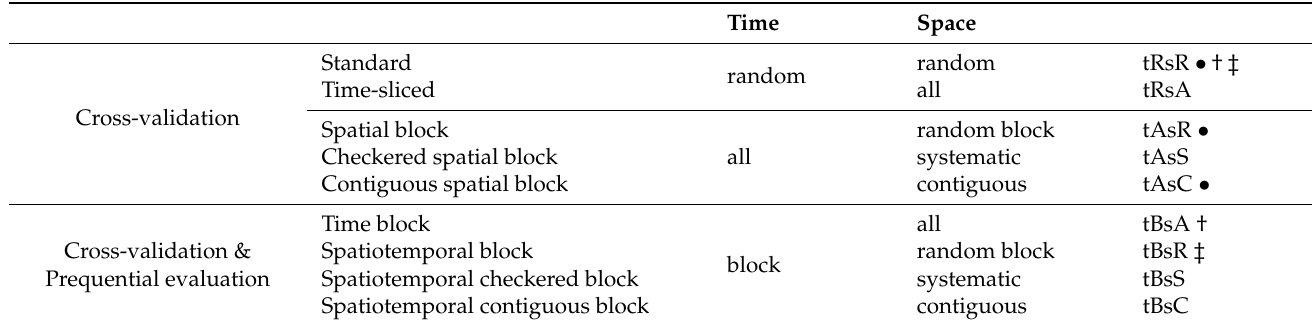
Figure 6. Buffered cross-validation. The folds used for training are in lighter lilac, the folds used for testing are in dark orange and buffer observations are in white. Table 1 summarises the different train/test assignment procedures used for CV and prequential evaluation methods. Table 1. Cross-validation and prequential evaluation fold assignment